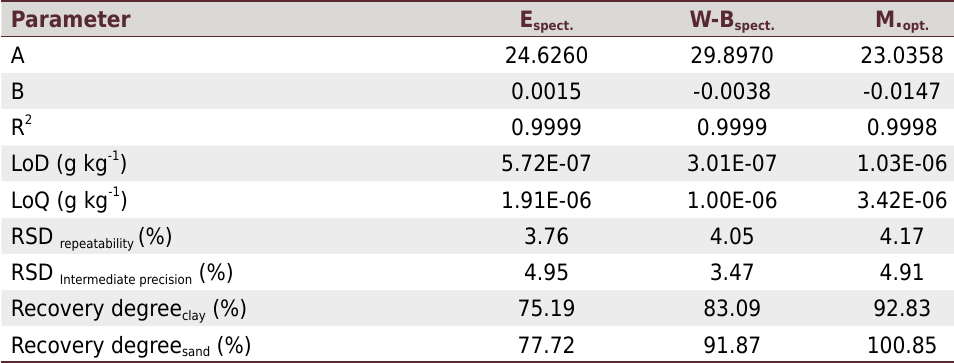
Table 5. Figures of merit estimated for both methods proposed